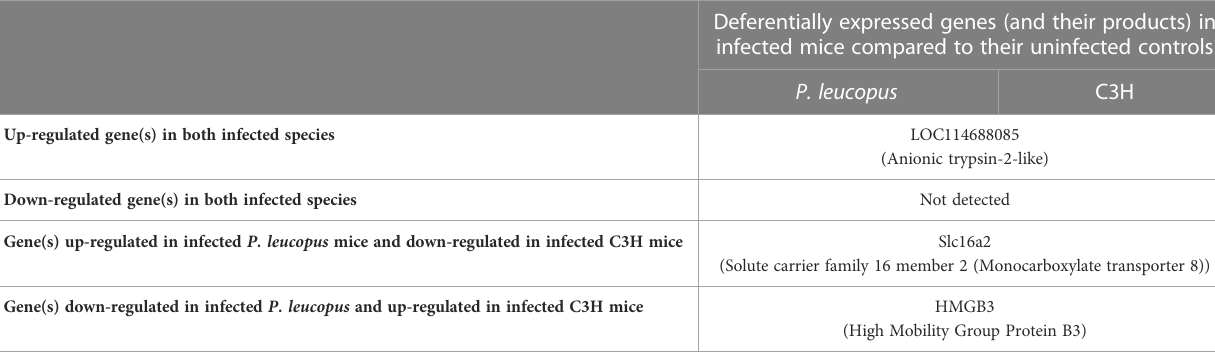
TABLE 1 A list of genes that are deferentially expressed in both Borreliella burgdorferi -infected Peromyscus leucopus and C3H mice. Up-regulated gene(s) in both infected species LOC114688085